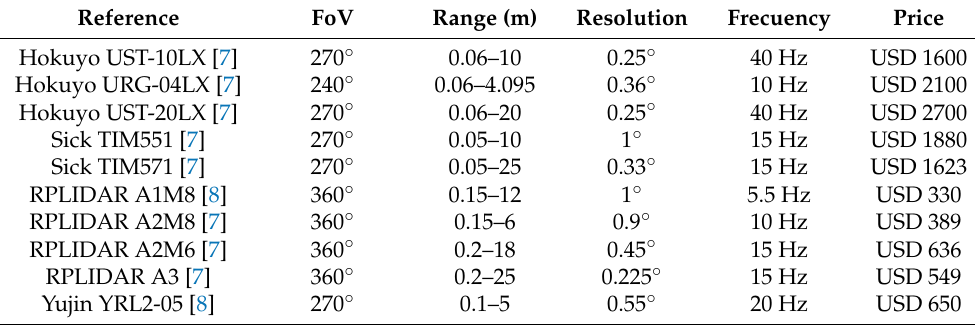
Table 2. Relevant characteristics of 2D LiDARs used for perception in service